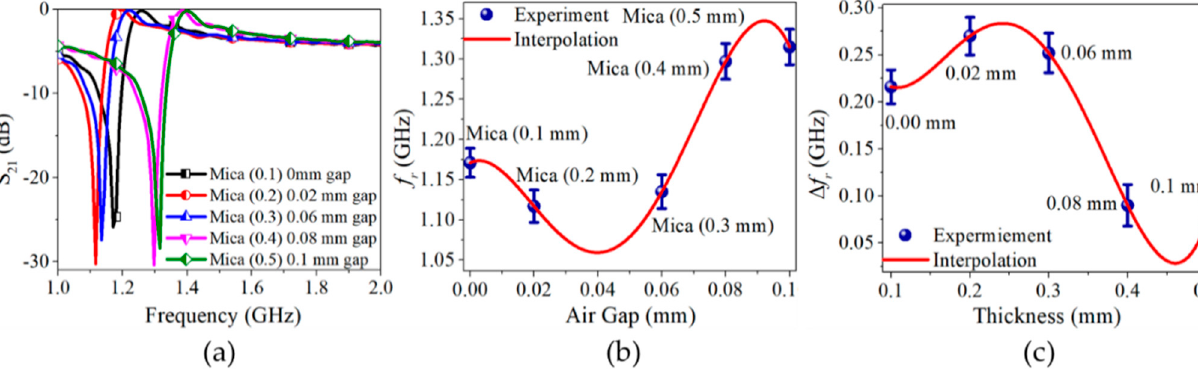
Table 4. Comparison of the designed sensor based on different performance characteristics.